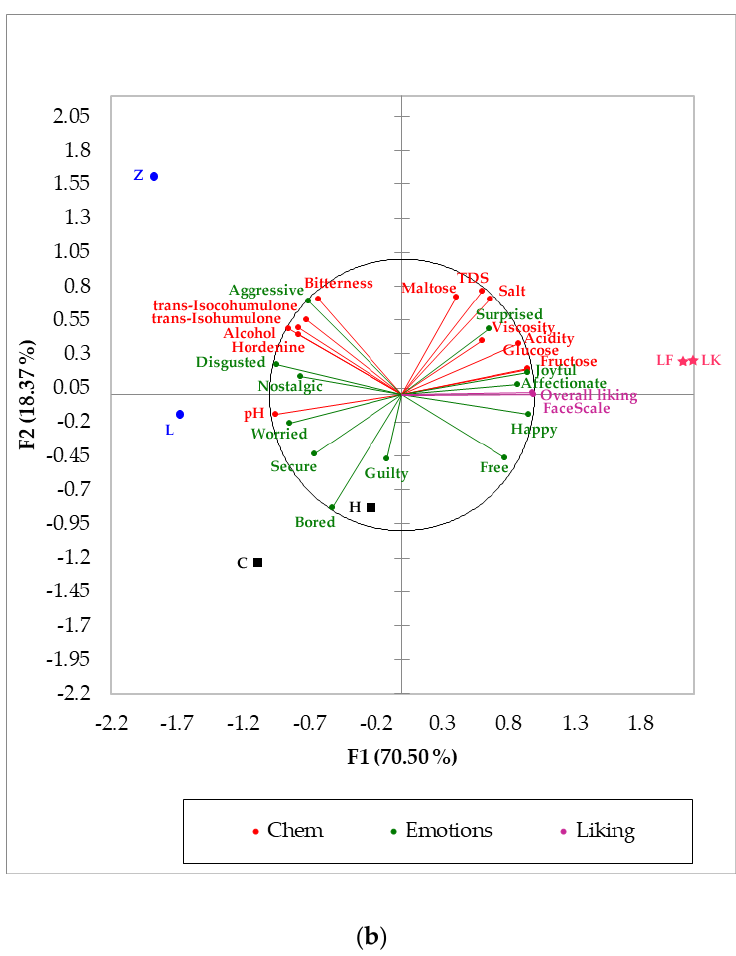
Figure 3. Multiple factor analysis showing the results from the sensory (self-reported liking responses), chemical data (Chem), and ( a ) emoji and ( b ) emotions, check all that apply responses. Abbreviations: F1 and F2 = Factor 1 and 2, TDS = total dissolved solids. Abbreviations for samples are shown in Table 1.